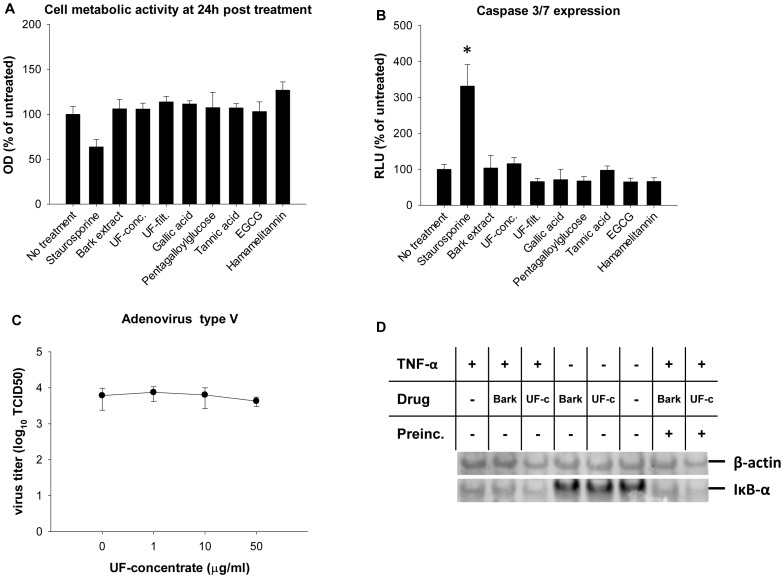
Determination of possible cytotoxicity or unspecific host cell receptor inhibition.(A) Cell metabolic activity after 24 h of incubation of A549 cells with DMSO (no treatment), 2.5 µM of staurosporine, 10 µg/ml of UF-concentrate or 50 µg/ml of the remaining drugs was determined in triplicates using XTT assay. Optical density (OD) was determined at 450 nm after background (650 nm) subtraction and expressed as % of the untreated samples. (B) Caspase 3/7 activity after 24 h of A549 cell incubation with DMSO (no treatment), 2.5 µM of staurosporine, 10 µg/ml of UF-concentrate or 50 µg/ml of the remaining drugs was assayed in at least triplicates using detection of a luminogenic caspase 3/7 cleavage product. (C) A549 cells were infected in triplicates with adenovirus type 5 (MOI of 0.05) and simultaneously treated with UF-concentrate. TCID50 was determined at 24 h post infection. (D) Interference of the drugs with cellular TNF-α signaling. A549 cells were preincubated for 30 or 0 minutes (“Preinc.”+or −, respectively) with 50 µg/ml of bark extract (“Bark”) or UF-concentrate (“UF-c”). Then, 0 or 30 ng/ml TNF-α were and 15 minutes later, total proteins were extracted. IκB-α and the loading control β-actin were detected on a Western blot using specific primary and Cy-5 and Cy-3 labeled secondary antibodies. * significantly elevated caspase expression (p<0.05) as compared to “No treatment”.